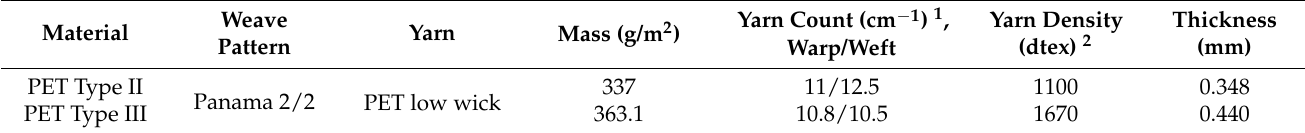
Table 1. Specifications of woven PET materials.